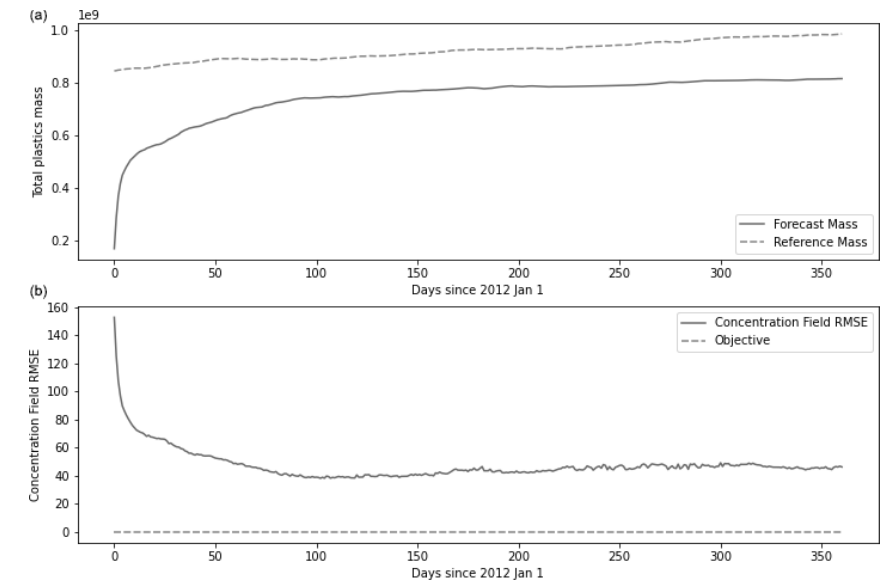
Figure 8. (a) Evolution of total plastic mass in the domain through 2012 for the reference simulation and the forecast simulation. (b) Evolution of the concentration field RMSE in the assimilation domain through the year 2012.